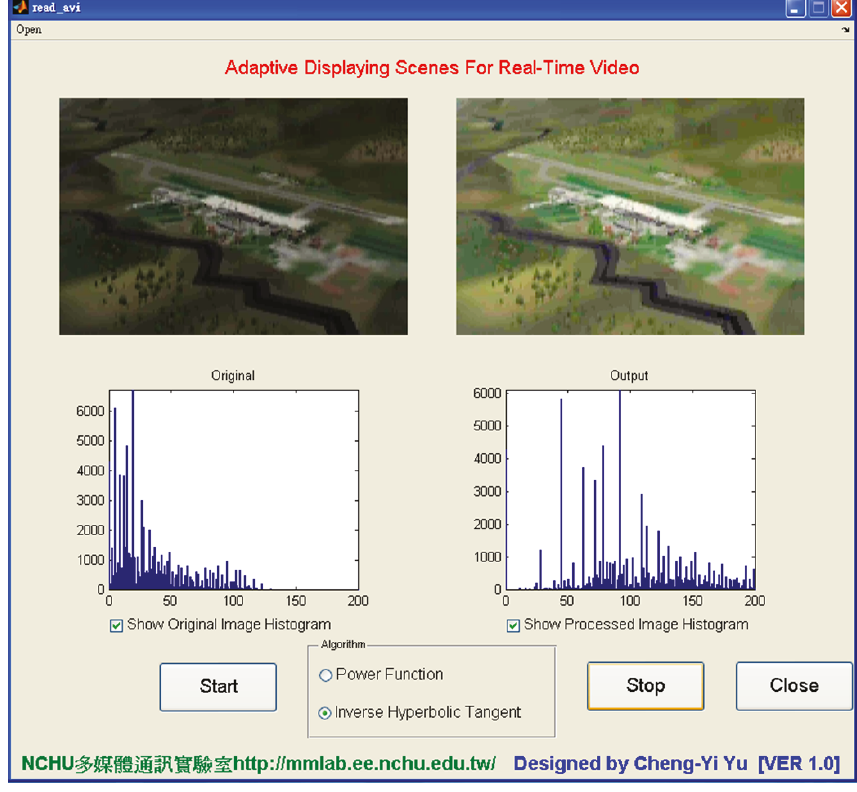
Figure 23: Enhancing the real-time image using the AIHT system. Table 2: MSE, SNR, and